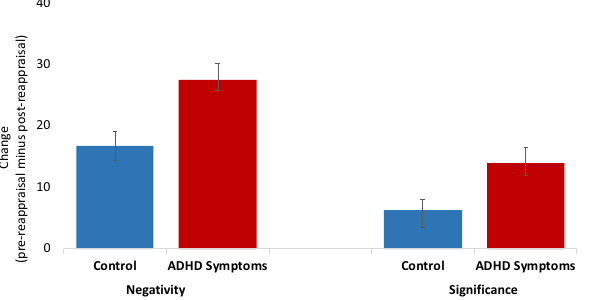
Figure 4. Comparison between the control and ADHD symptoms groups in the self-reported change in negativity and significance ratings. Change scores = ratings after writing the event (pre-reappraisal) minus ratings after the instructed reappraisal assignment (post-reappraisal). Higher positive values indicate a larger reduction in the negativity and significance ratings. Error bars represent standard